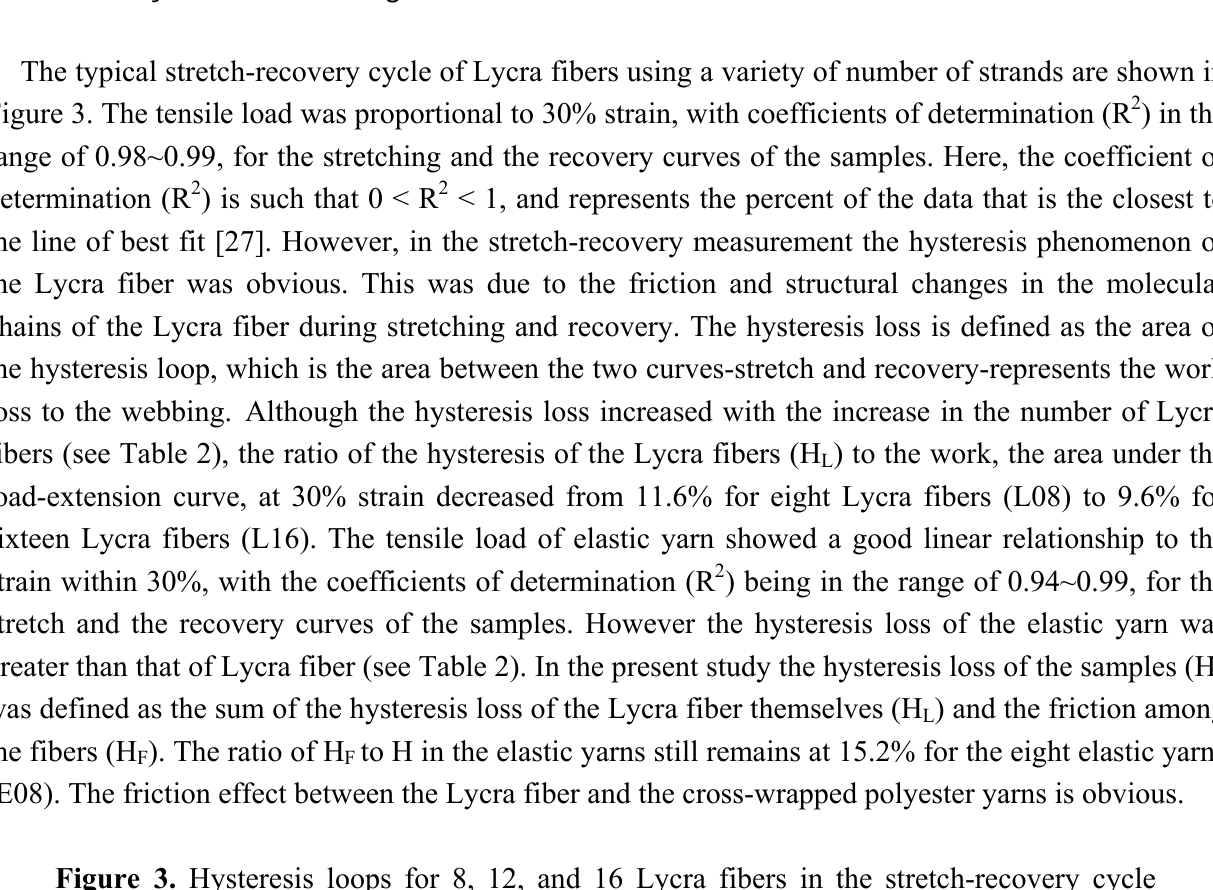
Figure 3. Hysteresis loops for 8, 12, and 16 Lycra fibers in the stretch-recovery cycle at 30%